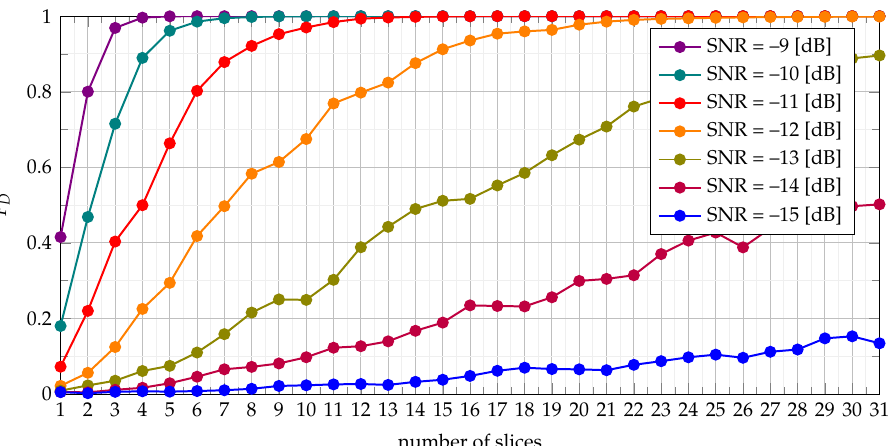
Figure 10. Dependence of the probability of detection on number of slices used in the TSCPF statistics for different SNR and P FA = 0.001.